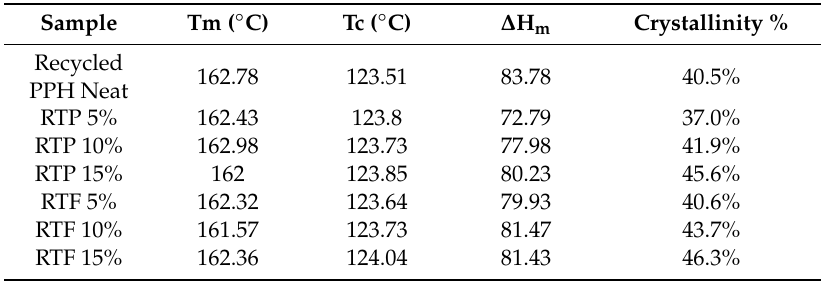
Table 6. Crystallinity index of treated fibers / PPH recycled matrix composites.